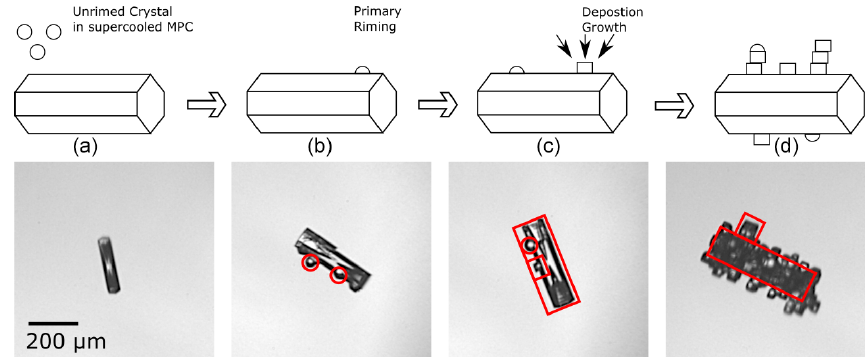
Figure 12. Schematic sketch of an epitaxially rimed column during different stages of the aging process: unrimed (a) , normally rimed (b) , mixed (c) , and epitaxially rimed column (d) . The lower panels shows corresponding exemplary PHIPS images (#1309, #1325, #1320, and #1368) acquired within a 45s segment in the presented case-study (shaded green area in Fig.